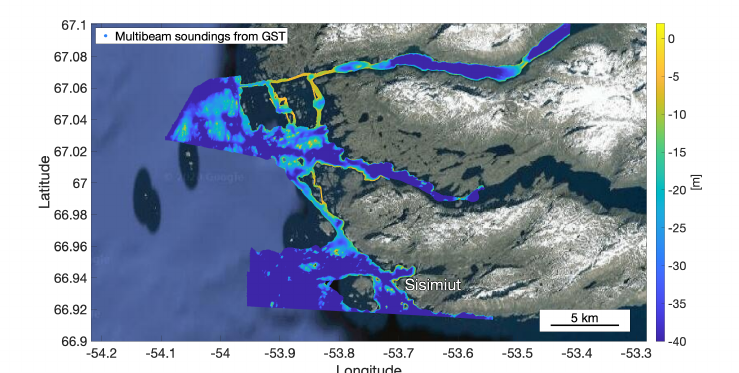
Figure 2. Multibeam echo sounding reference data in the area around Sisimiut,